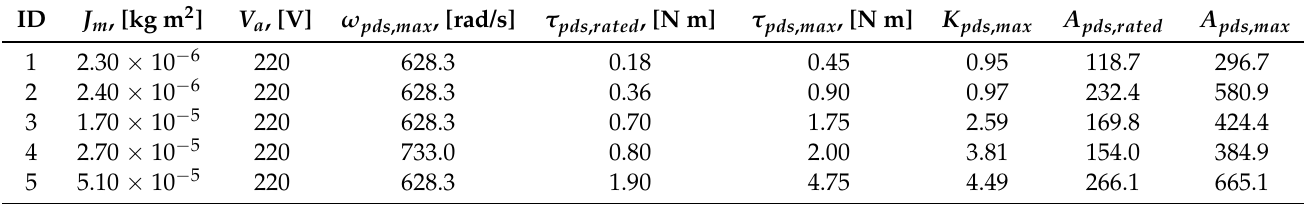
Table 2. Properties of the considered PDS candidates.